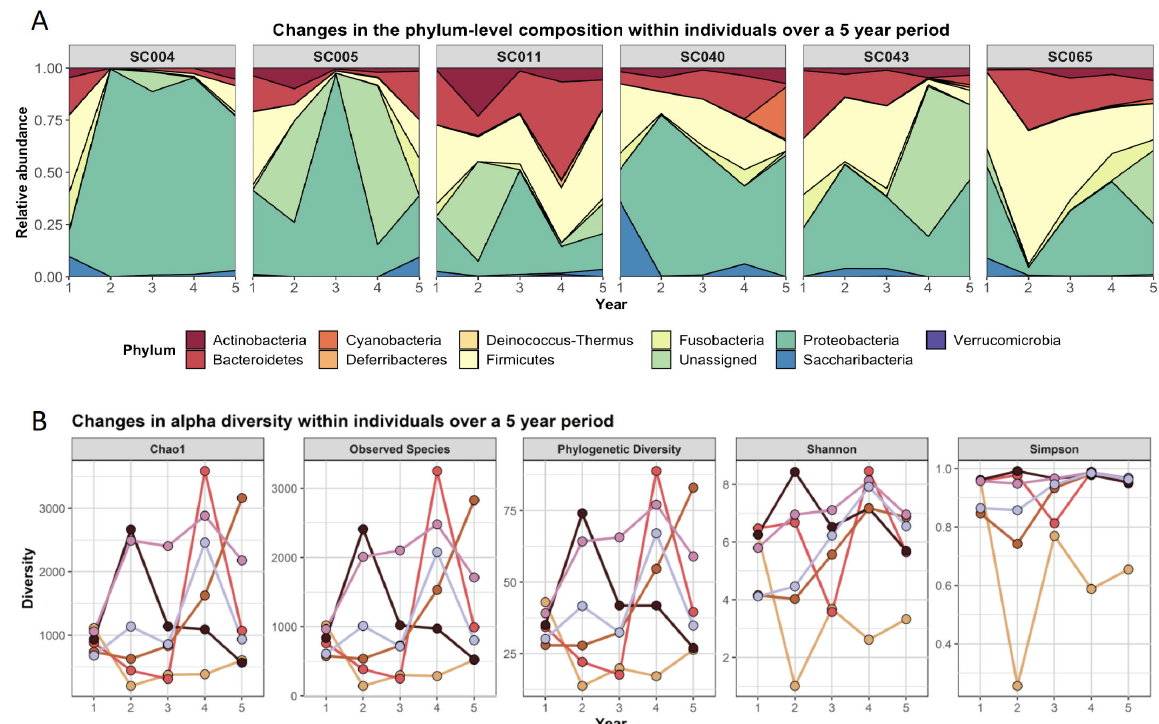
Figure 5. Longitudinal development of the CF airway microbiome over 5 years in six patients. ( A ) Relative phyla abundance and ( B ) alpha diversity in the CF lung